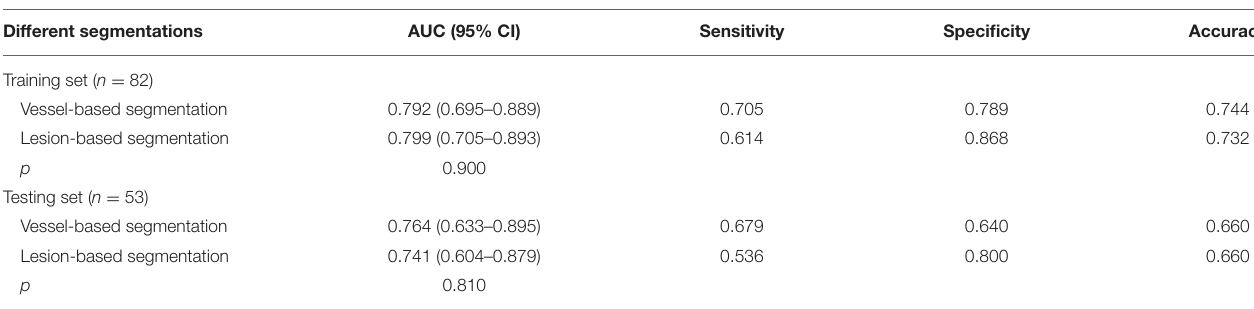
TABLE 4 | Discriminatory power of radiomics